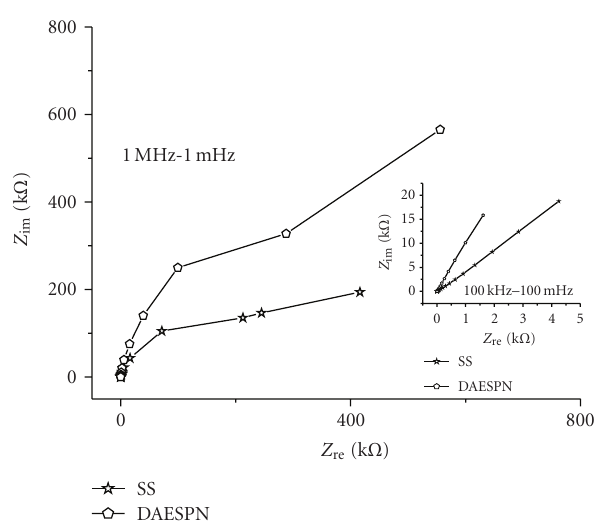
Figure 4: Nyquist plot of SS in the presence of 1 × 10 − 3 M DAESPN in 3.0M NaCl medium at di ff erent frequency range.